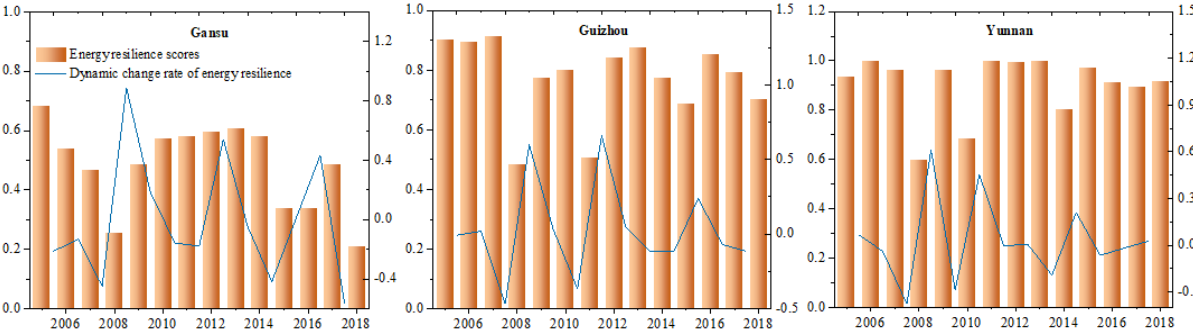
Figure 12. Energy resilience of the three least economically developed provinces in China.